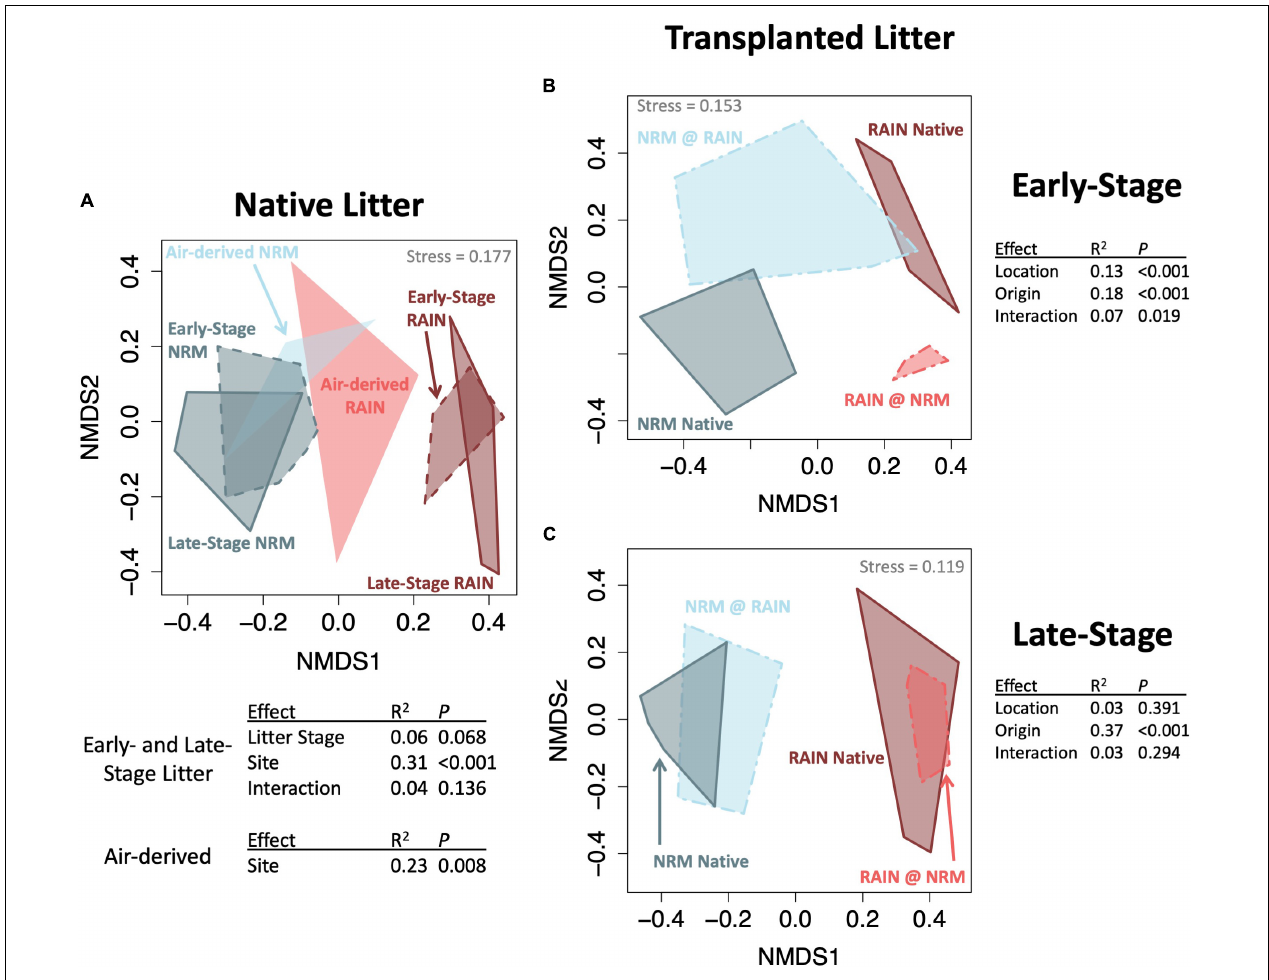
FIGURE 2 | NMDS ordinations (Bray-Curtis distance) of fungal communities with groups connected by convex hulls. (A) Native litter and air-derived fungal communities at both sites, top table shows the PERMANOVA just for litter communities and bottom table shows results for just air-derived communities (B) Transplanted early-stage litter with PERMANOVA results (C) Transplanted late-stage litter with PERMANOVA results.